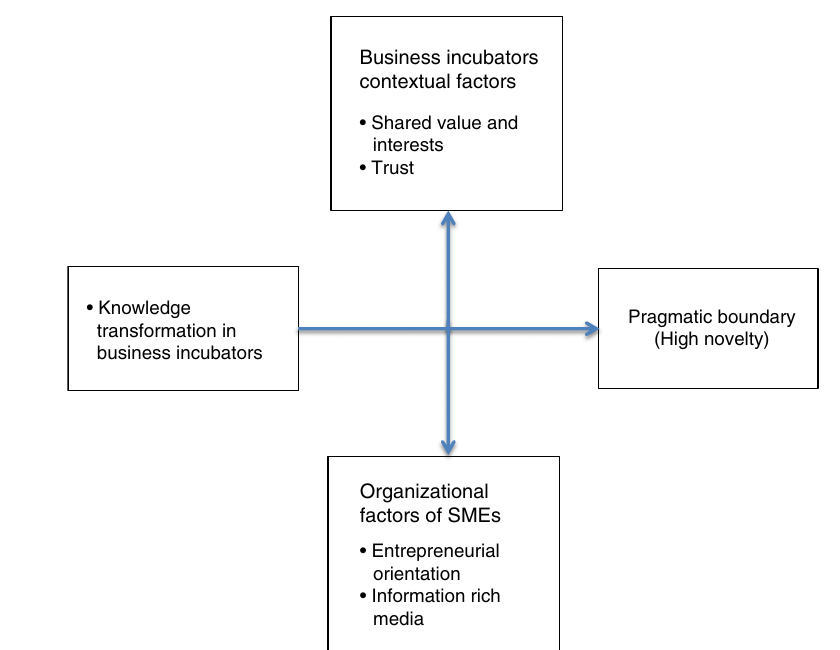
Figure 1. Proposed